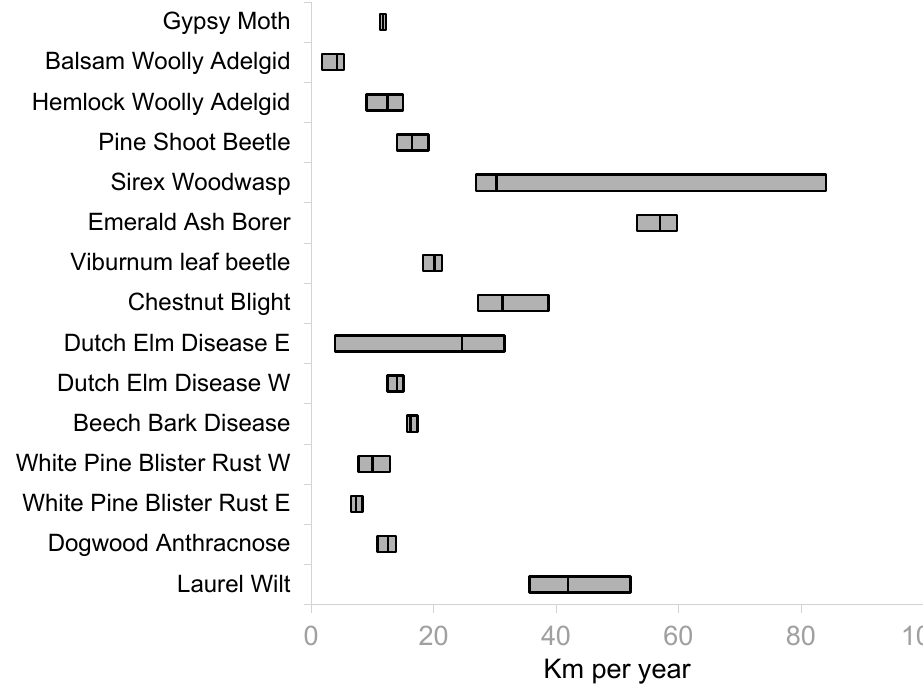
Figure 1. Center lines of boxes are the 50th quantile estimates for rate of spread with 90% confidence intervals in gray. The eastern and western infections of Dutch Elm Disease (DED) and White Pine Blister Rust (WPBR) were analyzed